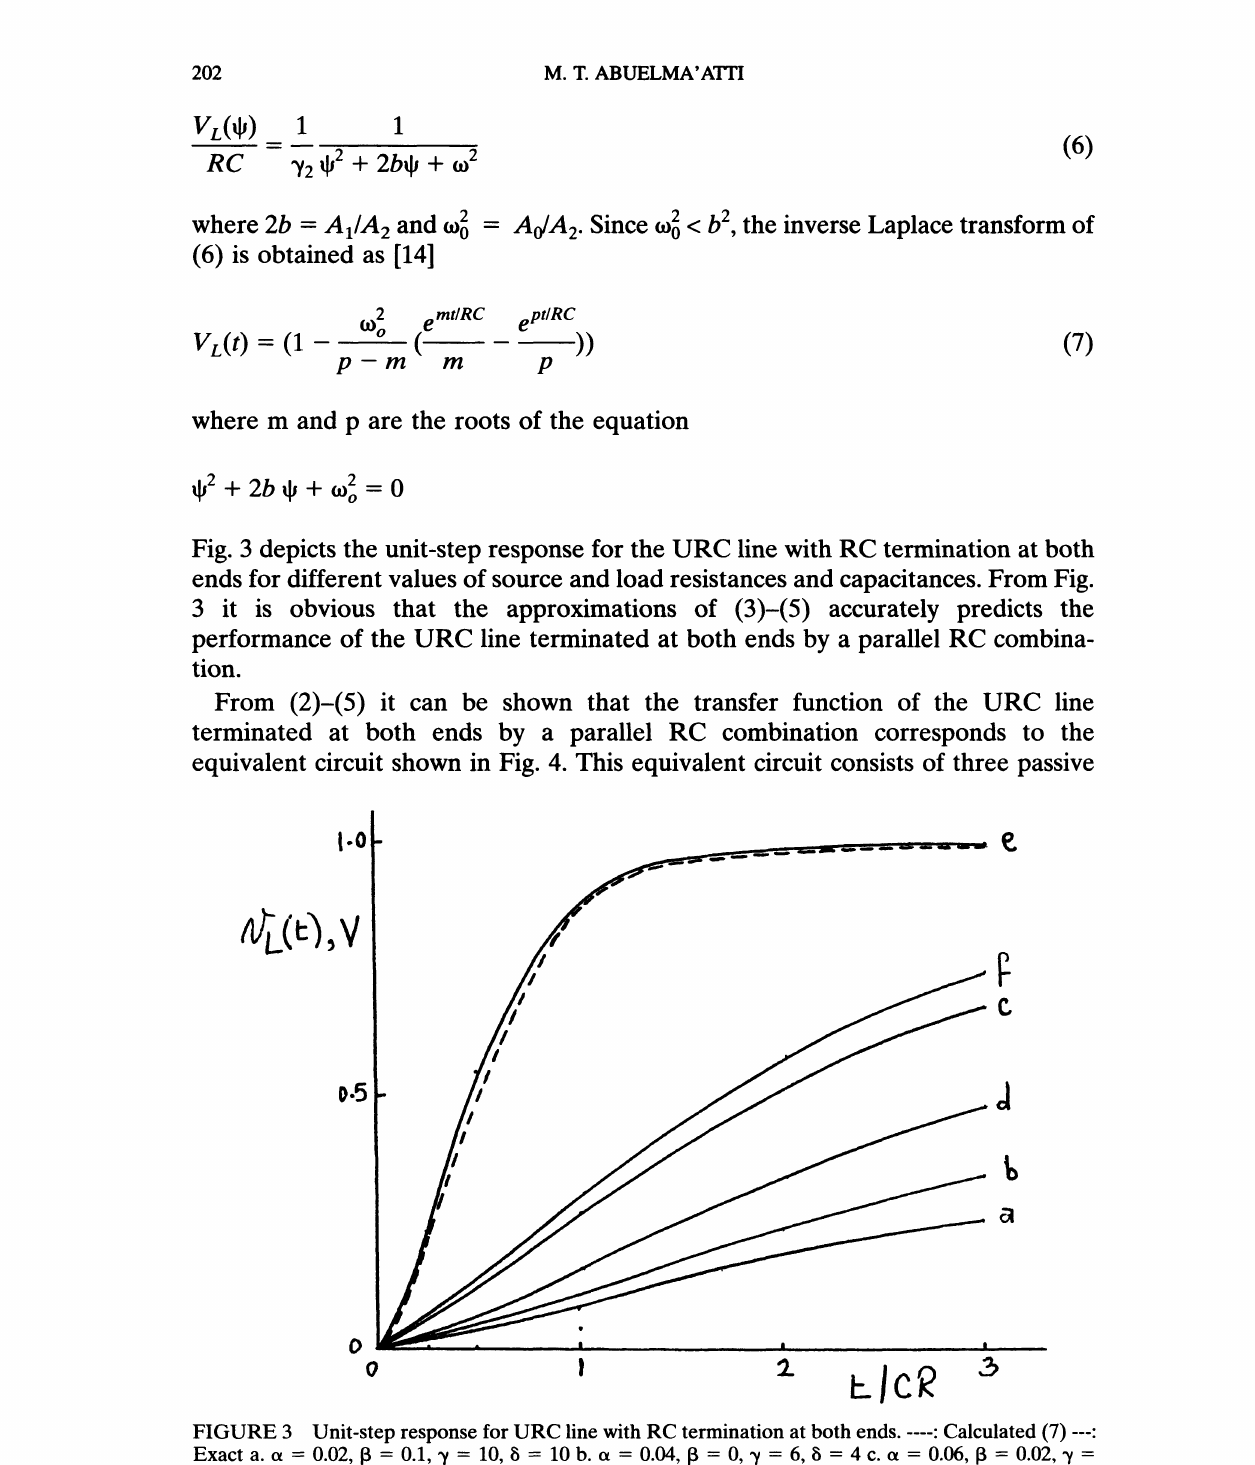
FIGURE 3 Unit-step response for URC line with RC termination at both ends.----: Calculated (7) ---: Exact a.